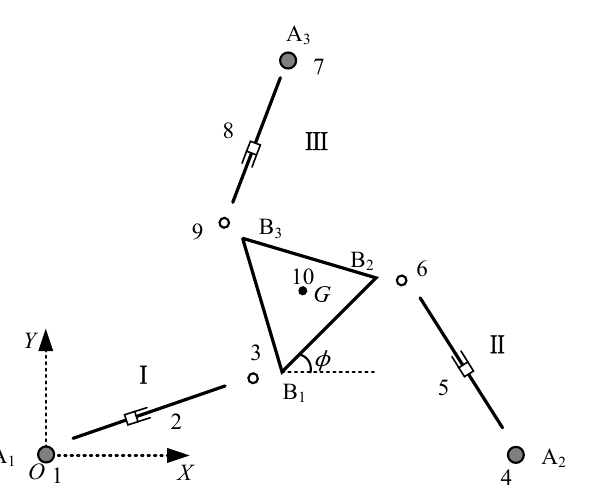
Figure 5. DT-TMM model of 3-RPR PPM.